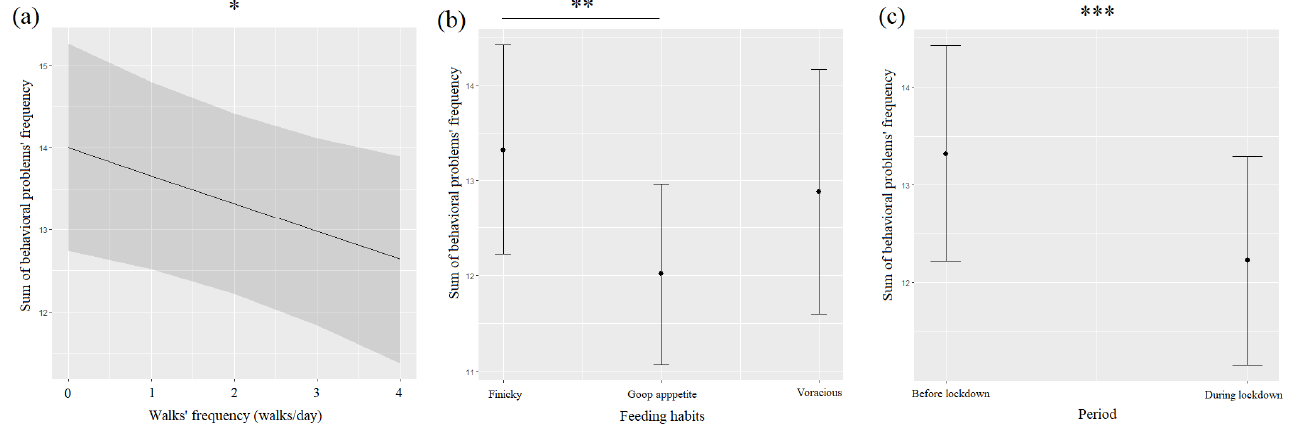
Figure 1. Means and 95% confidence intervals of dogs’ behavioral problems frequency depending walks frequency ( a ), dogs’ feeding habits ( b ), and period ( c ) extracted from linear mixed-effect